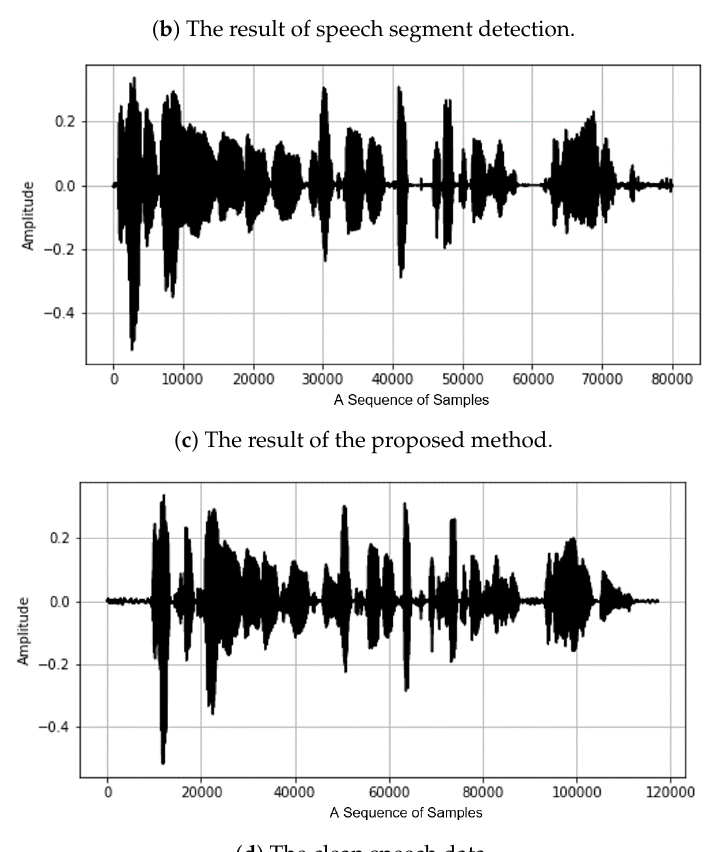
Figure 22. Denoised results of a sample p226 0